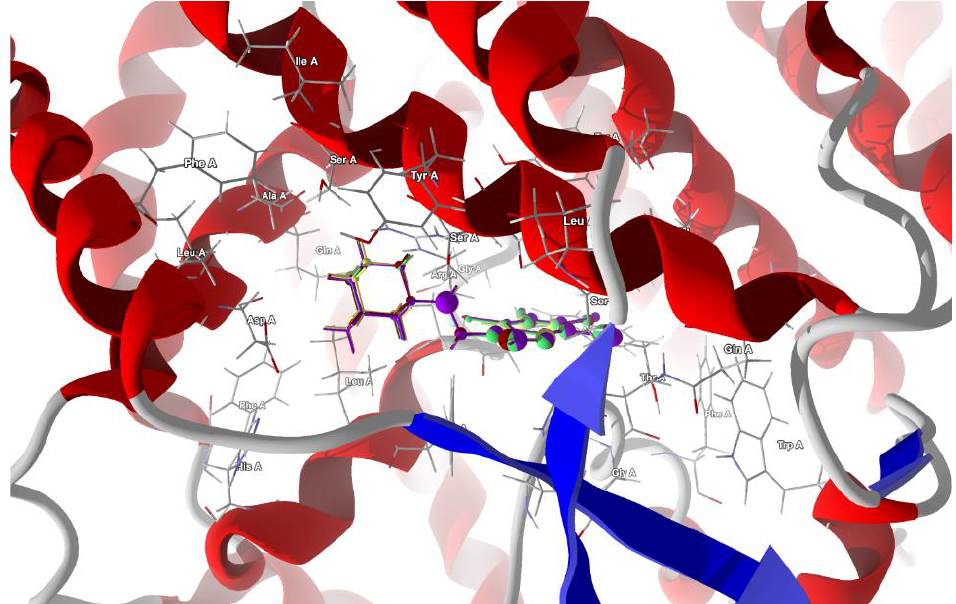
Figure 12. The docked poses of compound AB (yellow), tClAB (green), tBrAB (burgundy) and tIAB (purple) in binding site of Severe Acute Respiratory Syndrome Coronavirus 2, SARS-CoV-2 (6M17). The protein backbone is represented as a cartoon, the binding cavity residues are shown as sticks and docked ligands are shown as ball and stick (the size of the ball is proportional to the strength of the interactions).